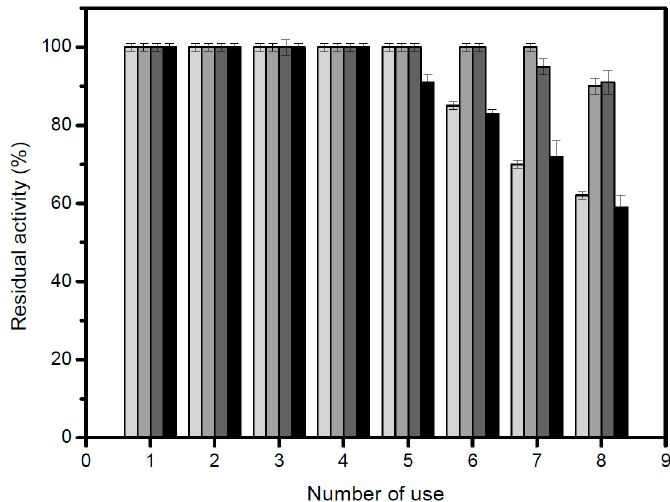
Figure 5. Operational stability of the lipase derivatives in repeated use conditions. Legends: light gray color, GX derivative; gray color, GA-crosslink derivative; dark gray color, GA derivative; black color, CNBr derivative.